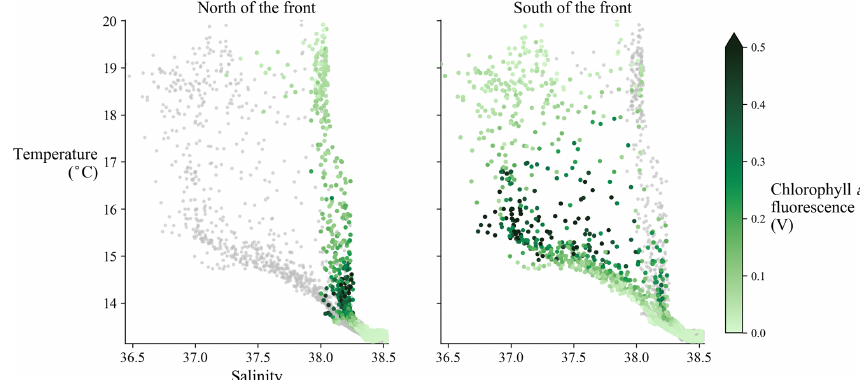
Figure 4. The T–S diagrams are shown separately for the casts located north and south of the front (broad, dashed line).